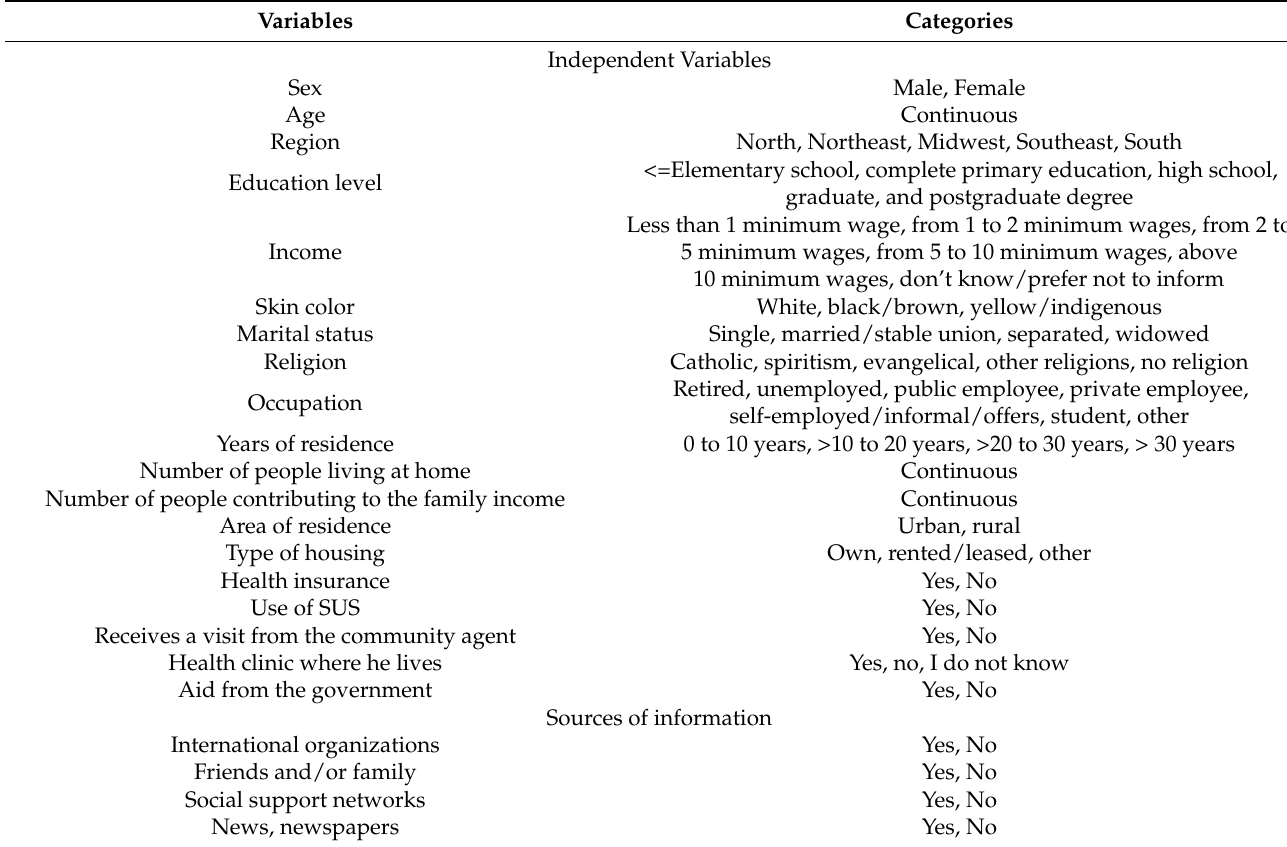
Table 1. Variables included in the present